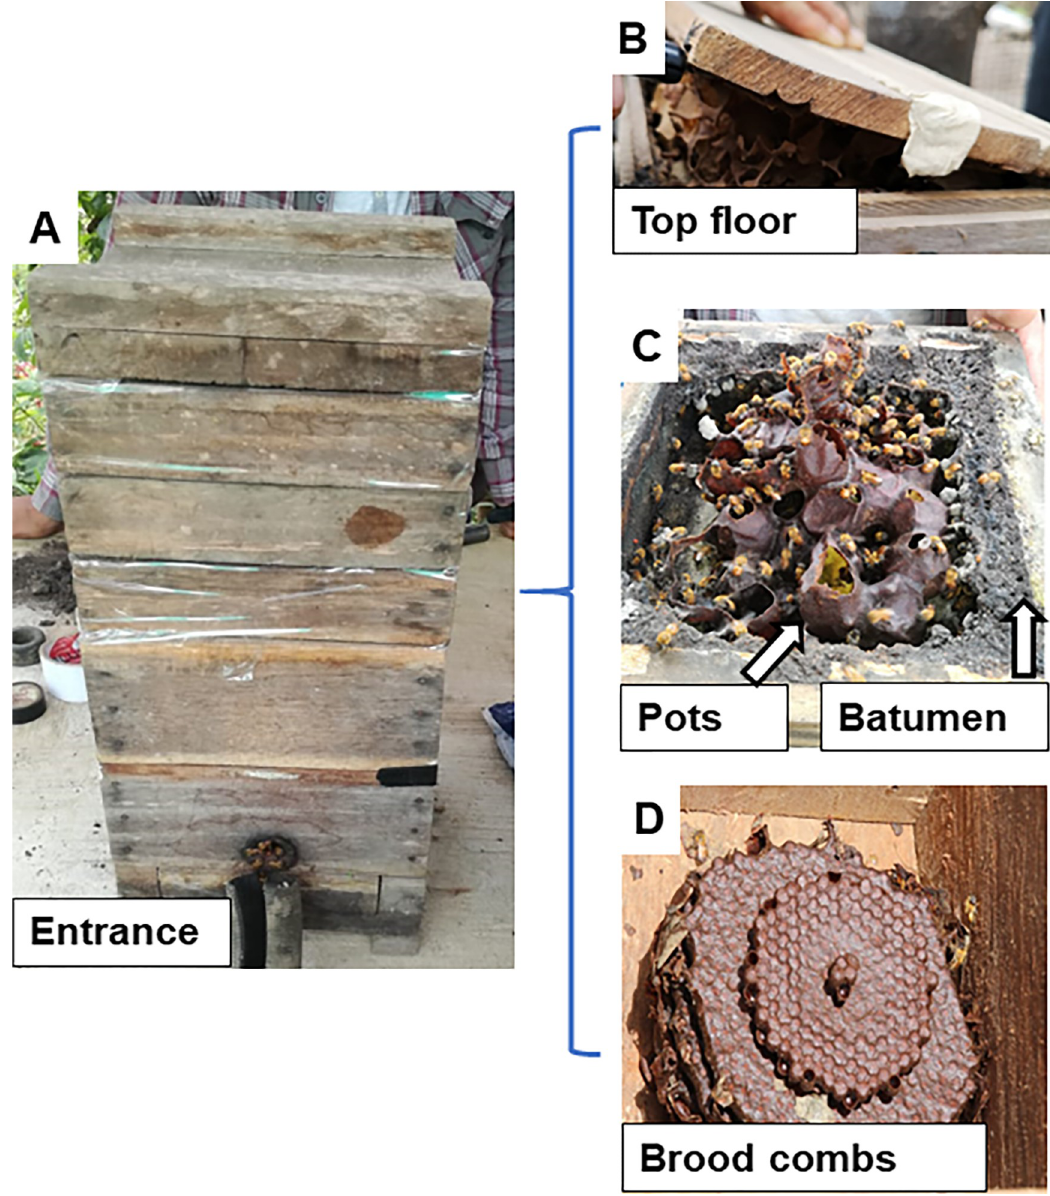
Fig 2. Technical nest of stingless bees in Ecuador. A) The nest consists in three main zones. B) top floor is the way by meliponicultor can open the nest and managed the bees. C) The storage zone cover by batumen (material made from resins and mug) contains honey and pollen pots. D) The brood chamber where different “plates or discs” are stacked in a column. Note : a natural nest has the same structure but inside a tree